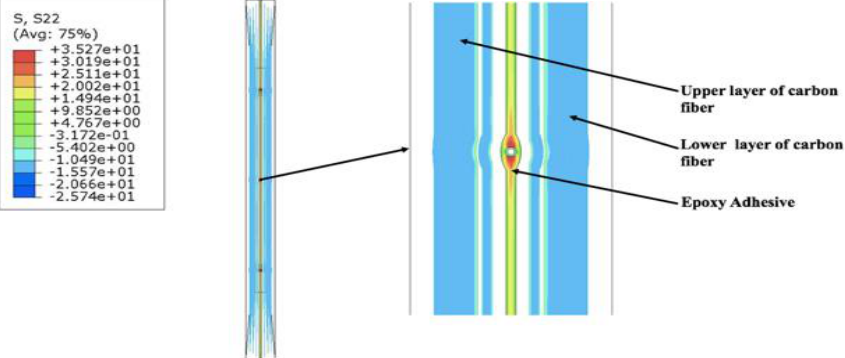
Figure 9. Stress distribution in the numerical model simulation having three FOSs in a linear placement.